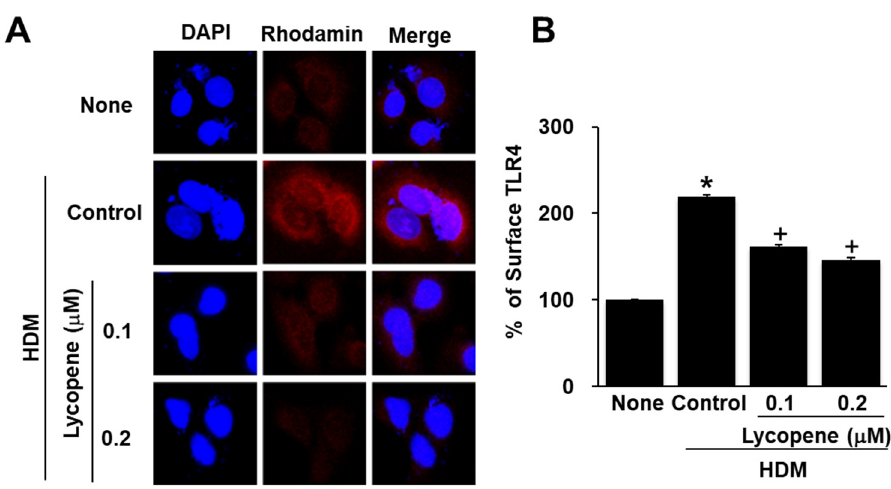
Figure 4. Effect of lycopene on TLR4 Activation in house dust mite (HDM)-stimulated A549 Cells. Cells were pretreated with lycopene (0.1 and 0.2 µ M) for 1 h and then with HDMs (20 µ g/mL) for 2 h. ( A ) The cells in slides were immunostained with a polyclonal antibody for TLR4. The immunoreactive proteins were visualized using a rhodamine-conjugated mouse anti-rabbit IgG antibody with DAPI counter-staining of the same field. ( B ) Surface TLR4 levels were examined by measuring the monoclonal anti-TLR4-MD-2 antibody conjugated with phycoerythrin (PE), using flow cytometry, and the mean fluorescence intensity was calculated thereafter. Surface TLR4 levels of the cells without any treatment (none) were set as 100%. All data are shown as the mean ± S.E. of three independent experiments. * p < 0.05 vs. none (cells without any treatment); + p < 0.05 vs. control (cells with HDM alone).